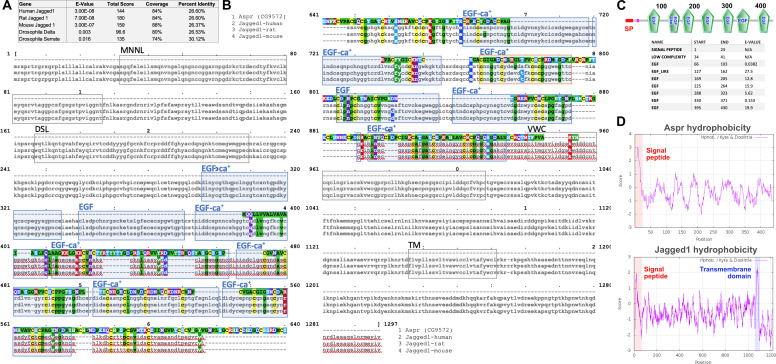
asperous (aspr, CG9572) peptide sequence is consistent with a non-membrane bound Notch ligand.(A) Table showing protein blast (blastp) results of Aspr against known Notch ligands of Drosophila (Delta and Serrate) and Jagged proteins of human, rat and mouse, showing a high similarity to the mammalian Jagged proteins, (B) Alignment of Aspr protein sequence with that of Jagged from human, rat and mouse, showing high regions of similarity in predicted EGF repeats. Blue boxes: Predicted EGF or EGF-ca+ domains in all species, Orange box: EGF repeat in mouse and rat. MNNL: N terminus of Notch ligand domain, DSL: Delta/Serrate/Lag-2 domain, VWC: von Willebrand factor type C domain, TM: Transmembrane domain, (Clustal omega, https://www.ebi.ac.uk/services), (C) Predicted domain structure of Aspr showing EGF repeats (green) and an N terminal signal peptide (SP, red box), Coordinates of the predicted domains in Aspr, and their expected value is shown, (SMART protein annotation tool, http://smart.embl-heidelberg.de), (D) Hydropathy plots of the Aspr peptide sequence and mouse Jag1, showing the N-terminal hydrophobic signal peptide sequence (red box), and the transmembrane region in Jag1 (blue box) that is absent from Aspr, (ProtScale, https://web.expasy.org/protscale).